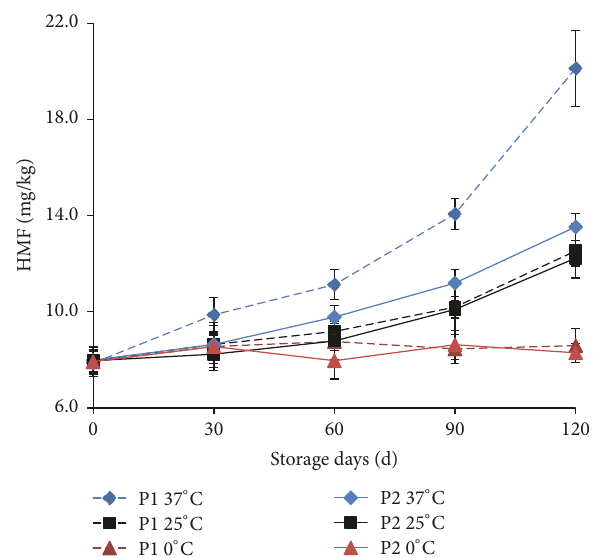
Figure 3: Changes of HMF in THPS during storage. The experi- ments were performed in triplicate, and results were expressed as the means ± standard deviation